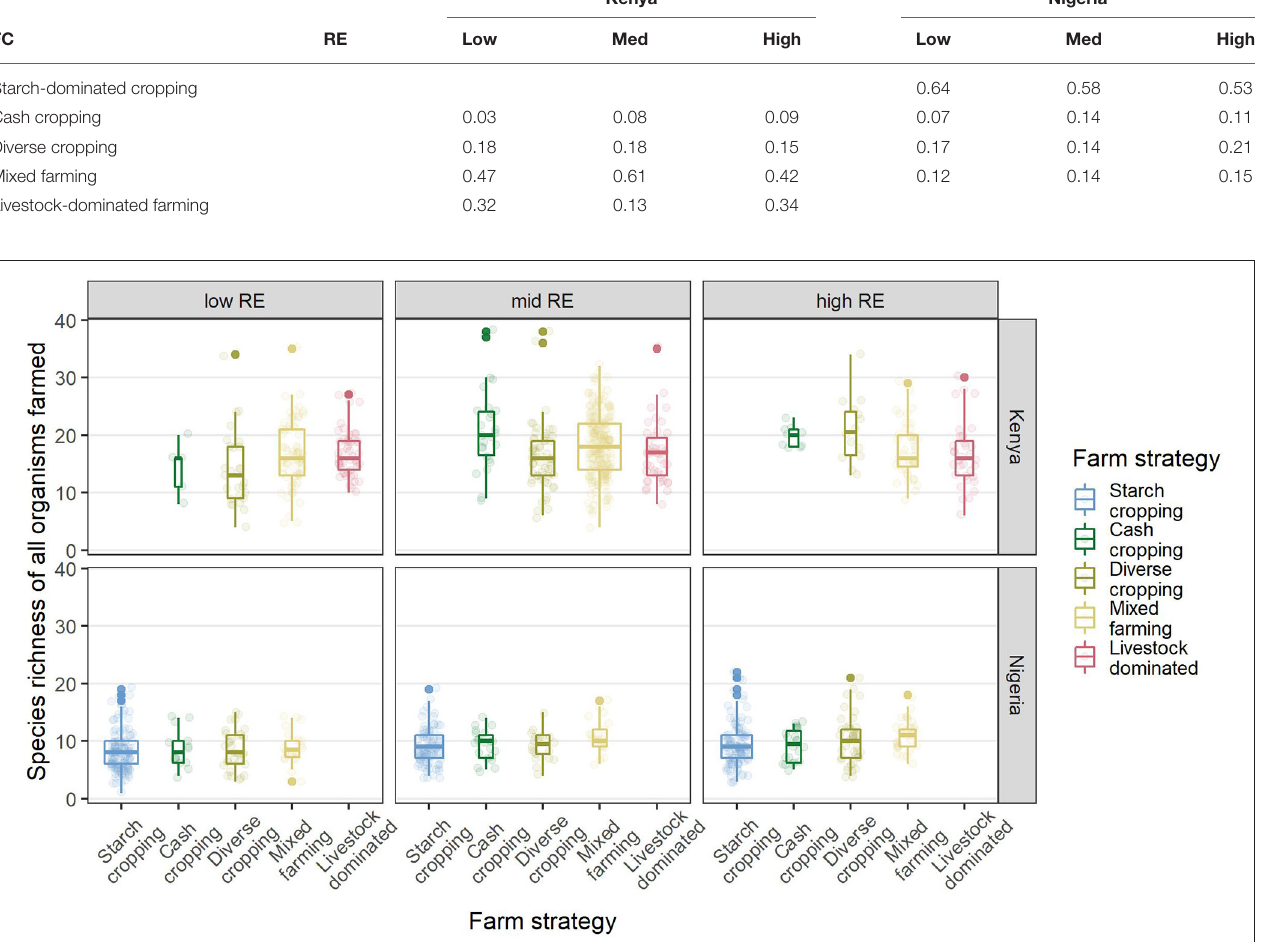
TABLE 2 | The proportion of farms within each FC (rows) for each RE group (columns), in each country. Kenya Nigeria